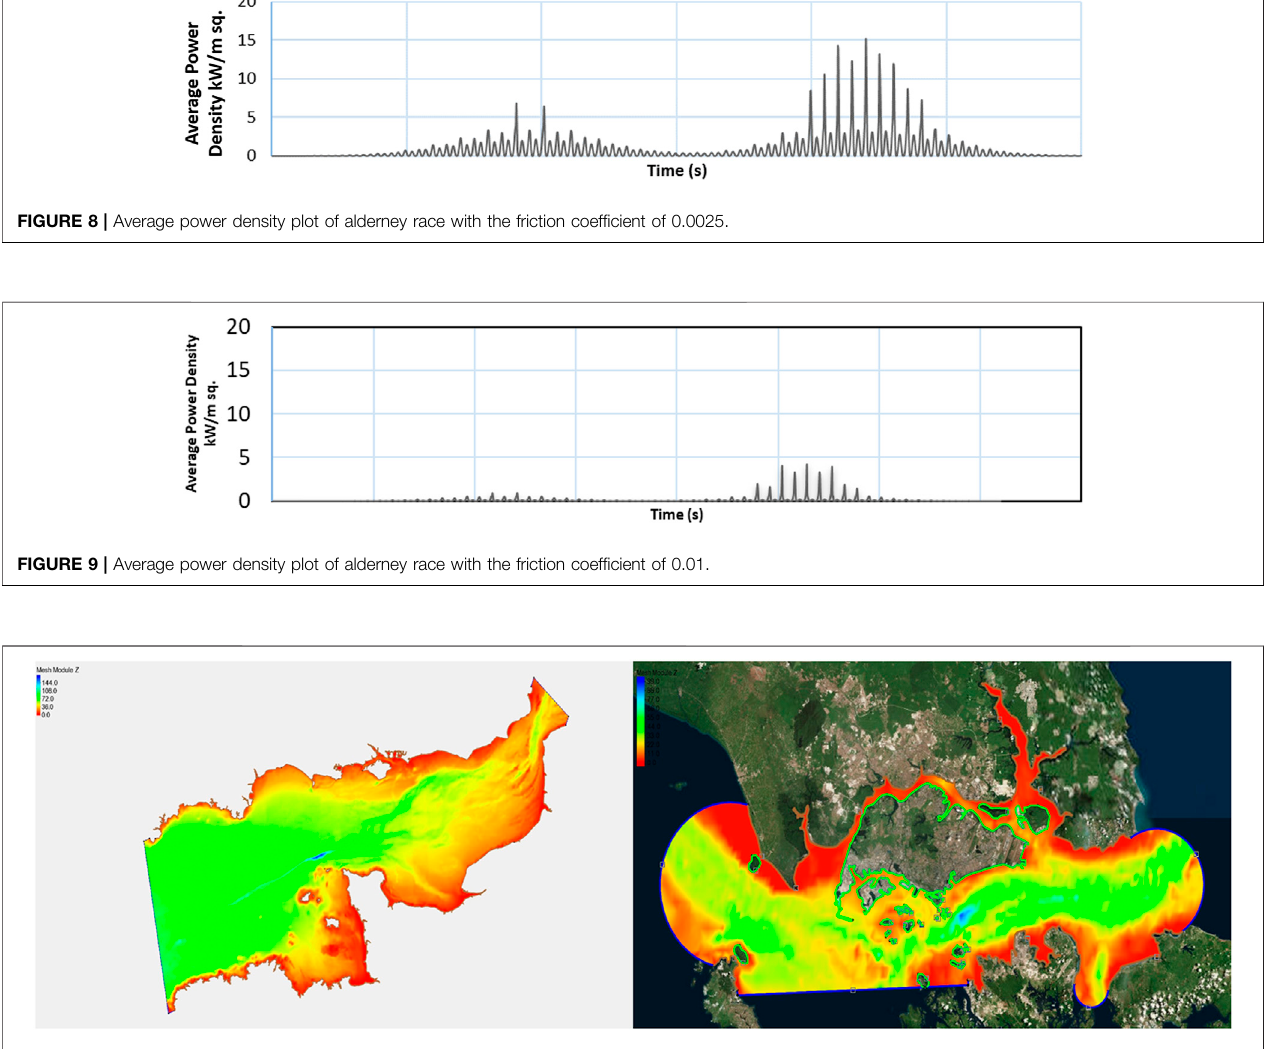
FIGURE 10 | Depth contour of alderney race and